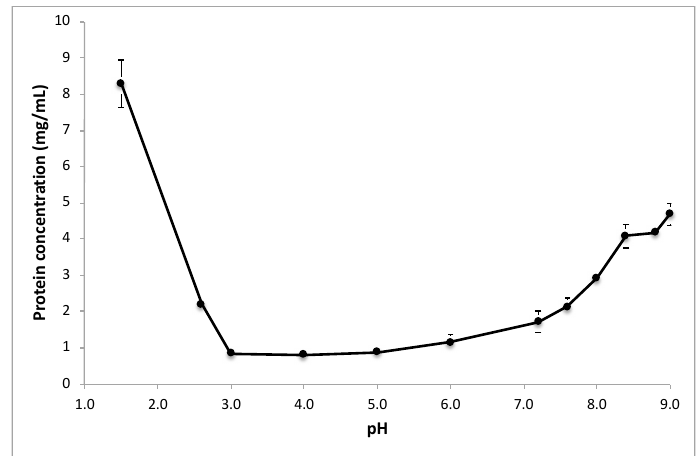
Figure 1. Protein release from light roasted peanut flour at various pHs. Extraction was conducted for 90 min at room temperature. Protein concentrations are shown, as measured with the BCA method (mean values of triplicate experiments; the bars show SD).